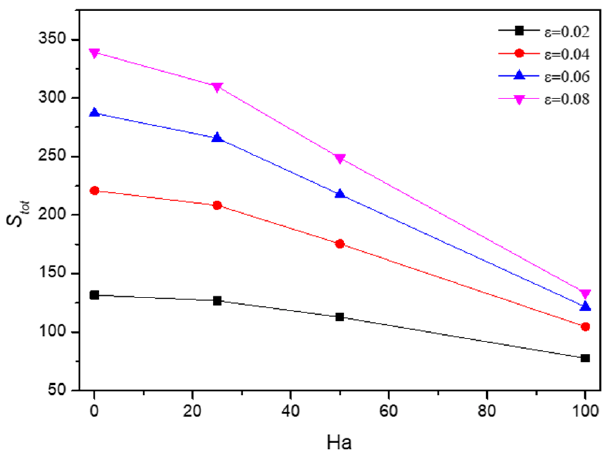
Figure 20. Total entropy as a function of Hartmann number (Ha) at various values of porosity 𝜀 (cid:3043) . Ra = 10 6 , 𝜙 = 0.02, and Da =